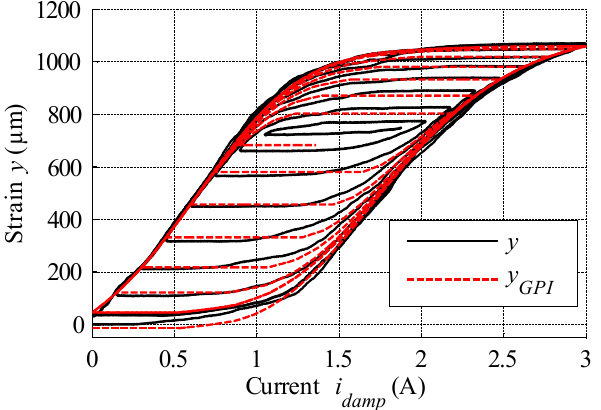
Table 2. Estimated GPIM parameters.